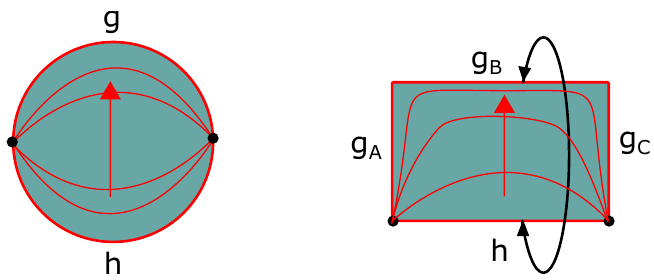
Figure 4 . The disk amplitude in the open channel (left). Hilbert space slicings are denoted in red. Deforming the amplitude (either preserving the area (YM), or the boundary length (BF)) into a rectangle (right), and identifying the upper and lower boundaries, one arrives at the fundamental cylinder